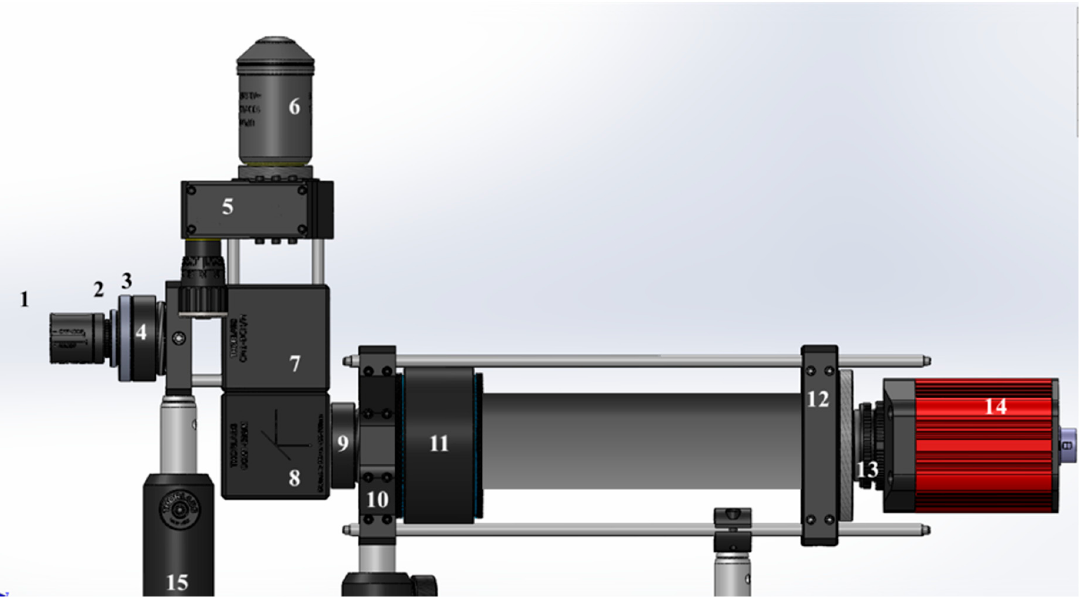
Figure 1. Schematic view of the imaging system components. CAD files for the components were obtained from the Thorlabs webpage and reproduced with permission. Copyright © 2020 Thorlabs. CAD files were assembled using SolidWorks. The numbered imaging components are listed in Table 1.